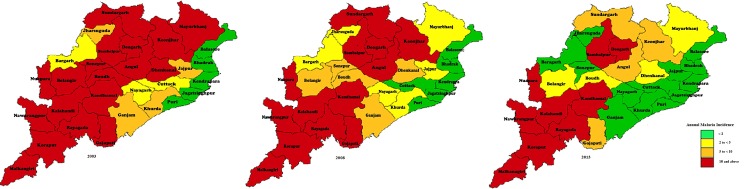
Annual malaria incidence (2003, 2008, and 2013), Odisha.